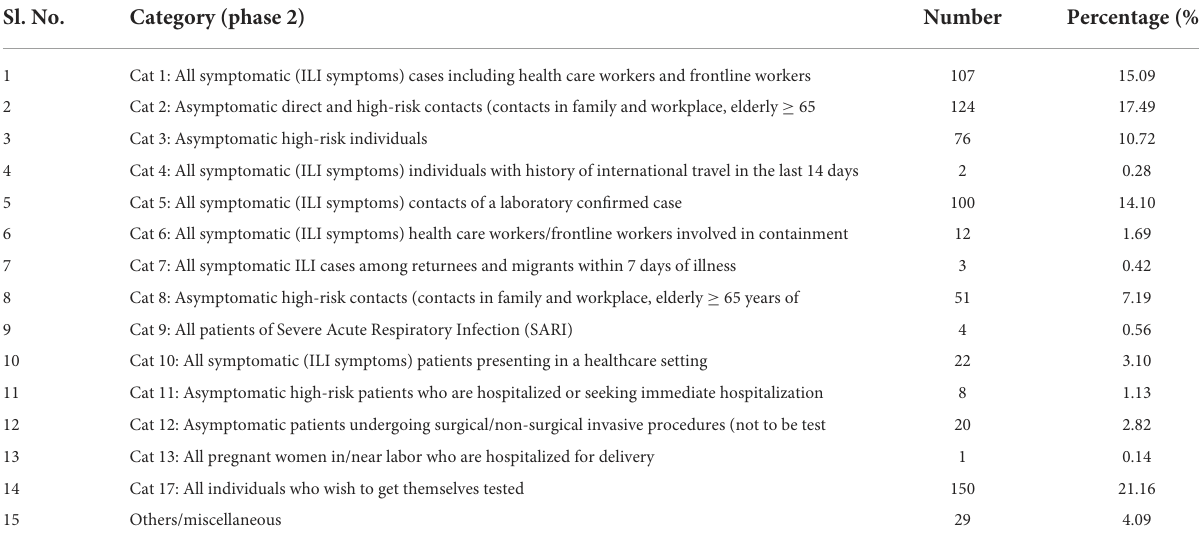
TABLE 3 Details of samples collected during phase 2 (January 2022 to May 2022) which met the inclusion criteria. Sl.